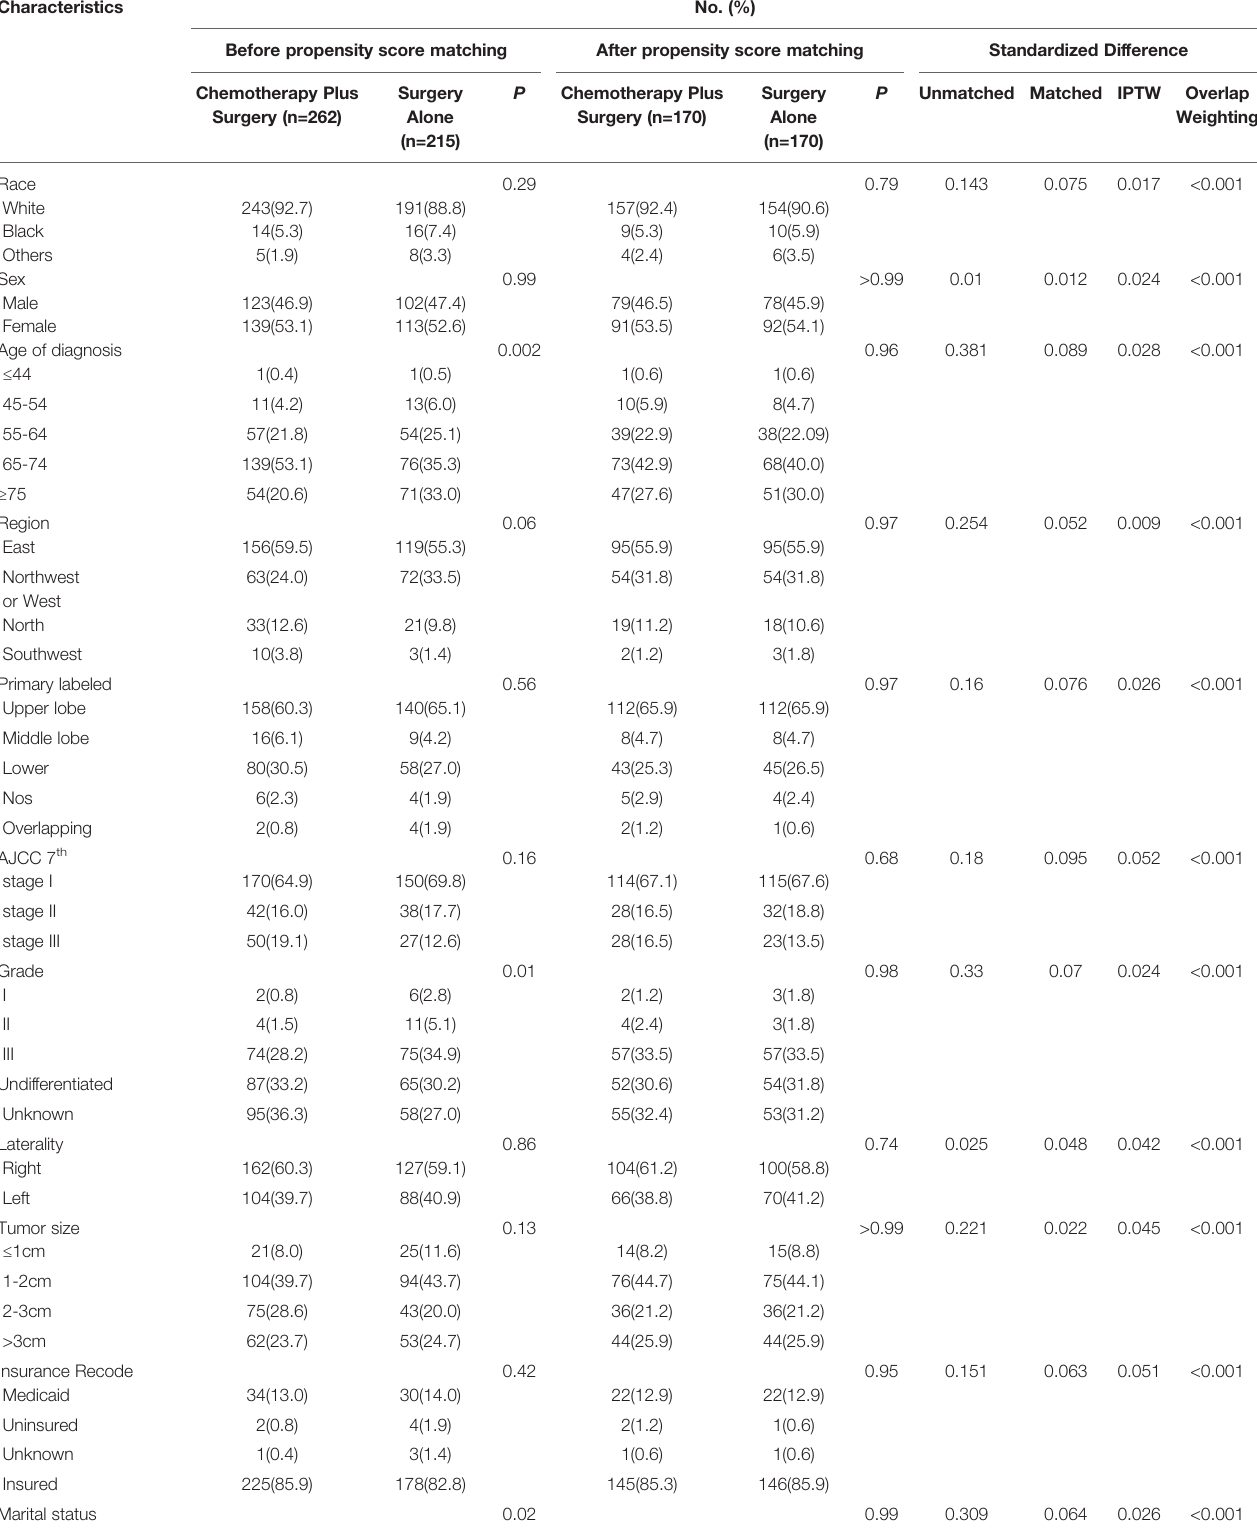
TABLE 1 | Demographic and clinical characteristics of patients with small cell lung cancer.